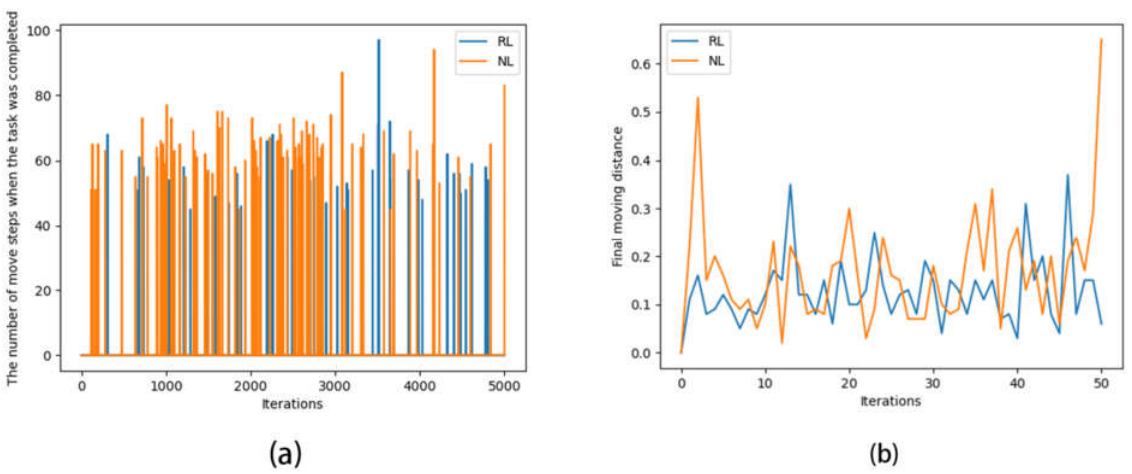
Figure 6. Algorithm comparison results. ( a ) Diagram of the number of moving steps when the task was completed; ( b ) change chart of final moving distance.